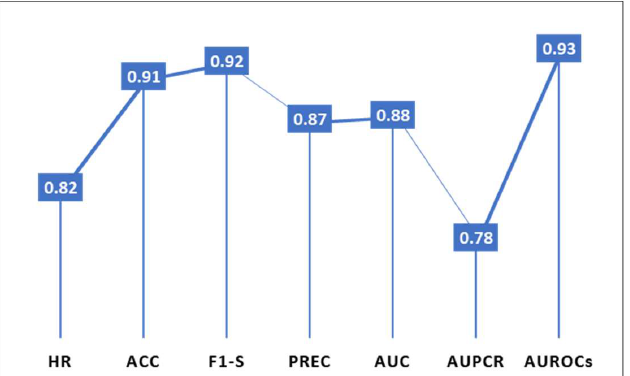
Figure 3. Average performance of the metrics used in the observed studies.